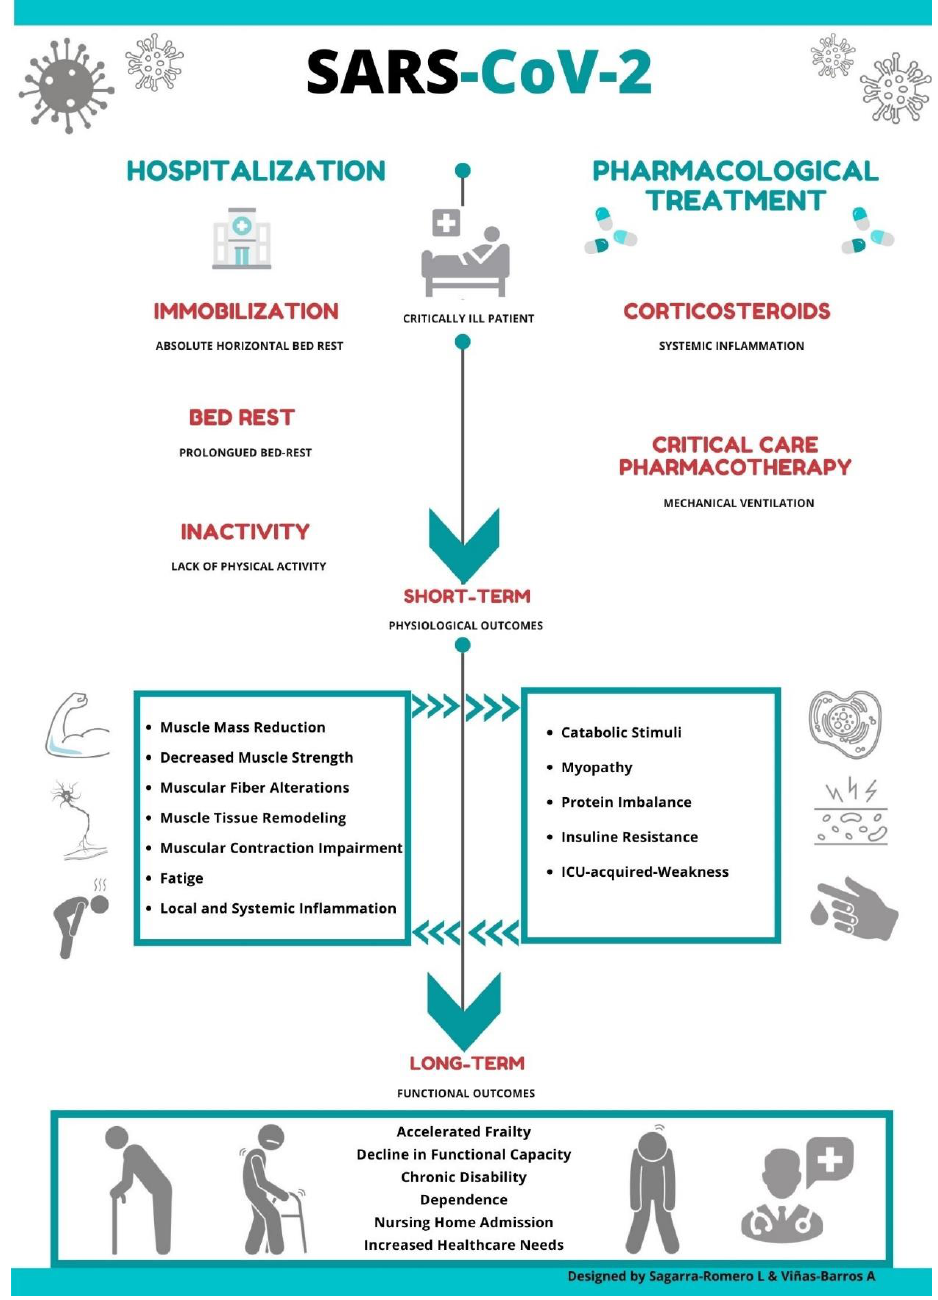
Figure 1. The effect of drug therapy treatment and long periods of bed rest on muscular weakness in elderly patients infected with COVID-19.